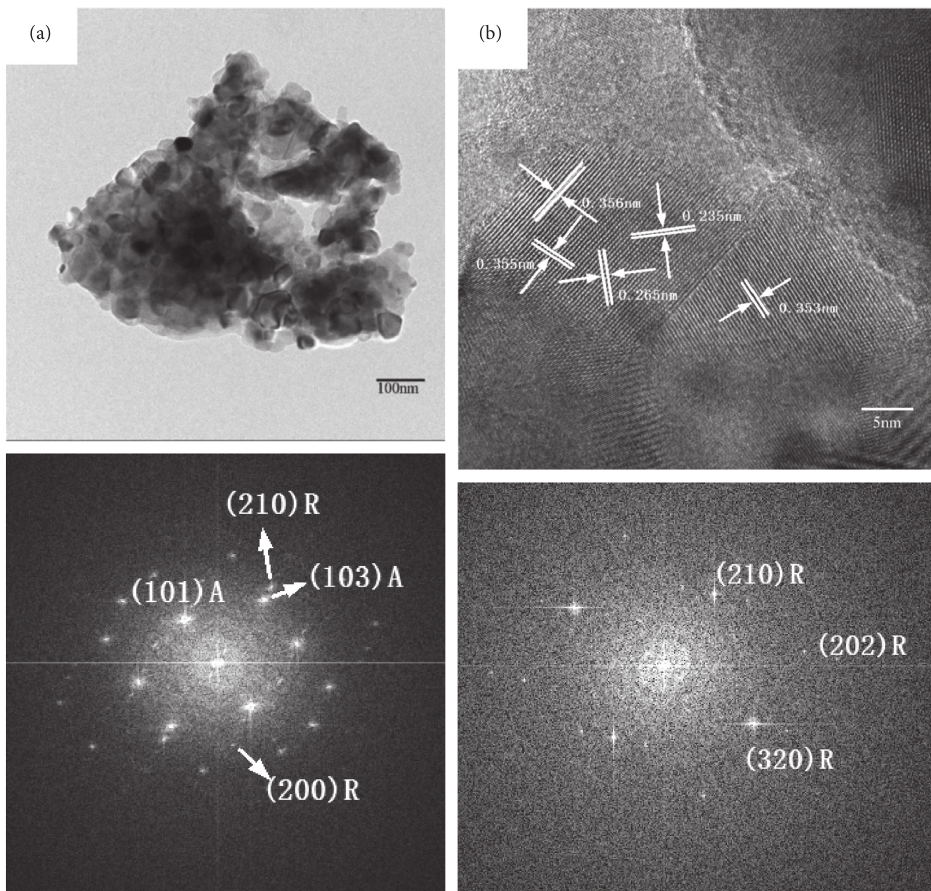
Figure 8: The TEM images of 5 mol% Cu-doped TiO